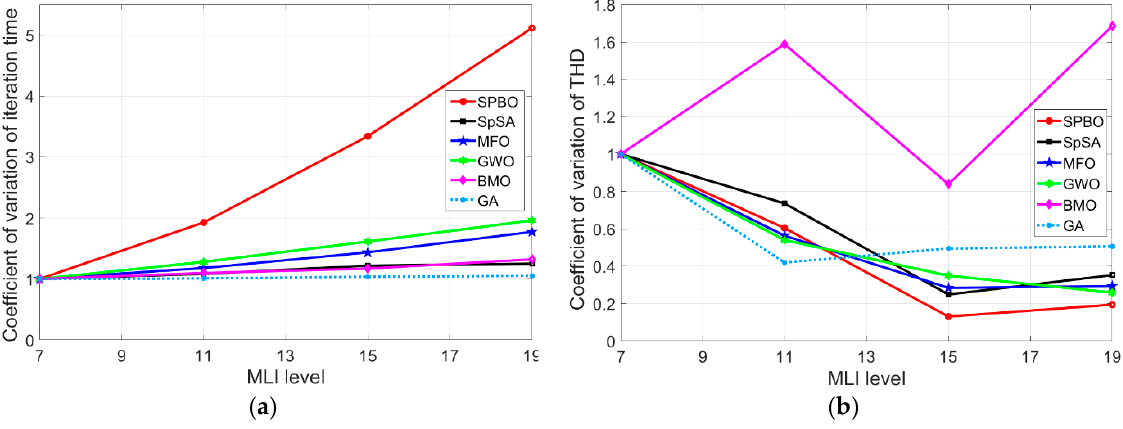
Figure 4. Coefficient of variation of ( a ) iteration time; ( b ) THD.